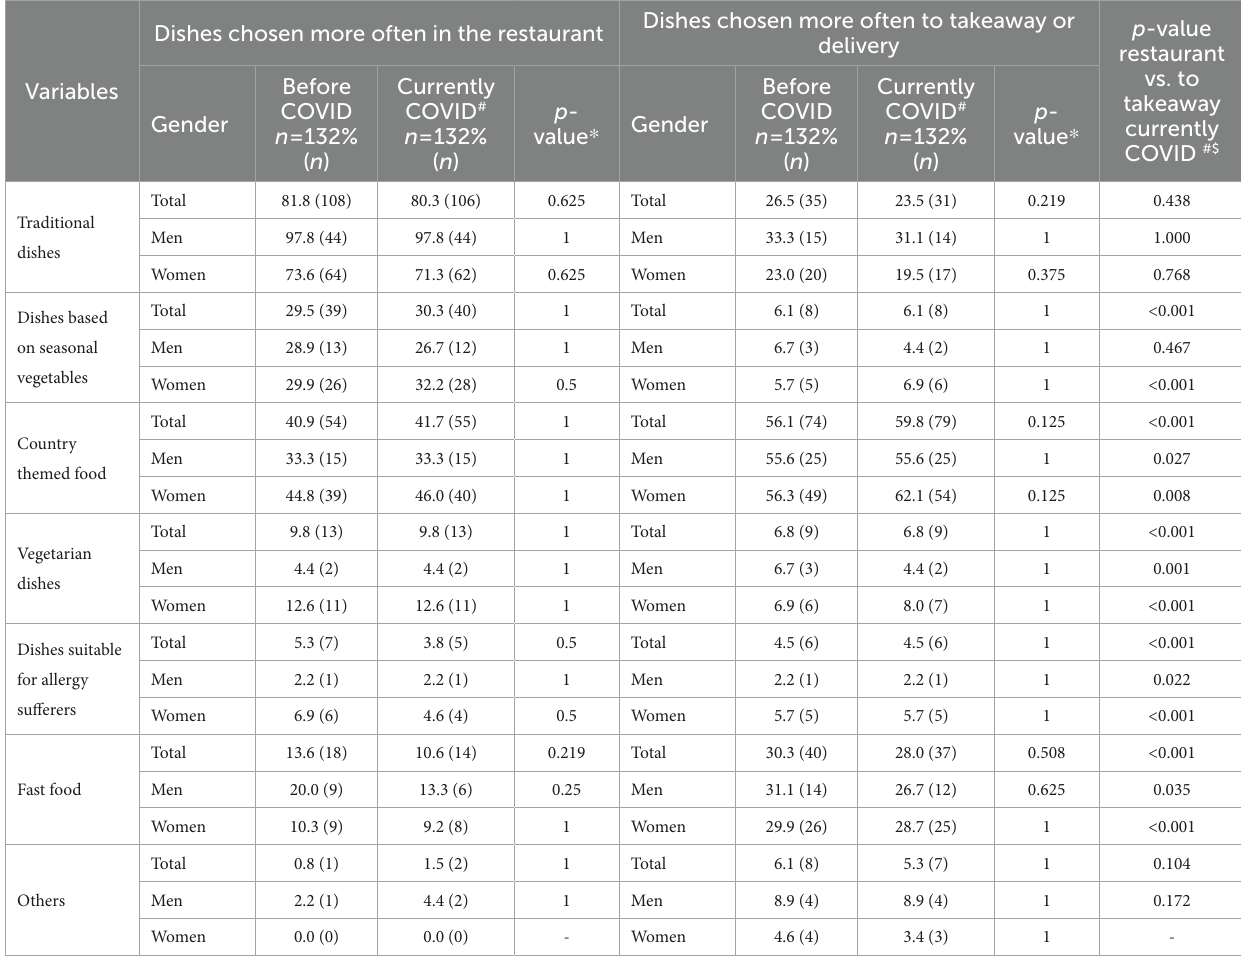
TABLE 3 Preferences and comparison of dishes in the restaurant or